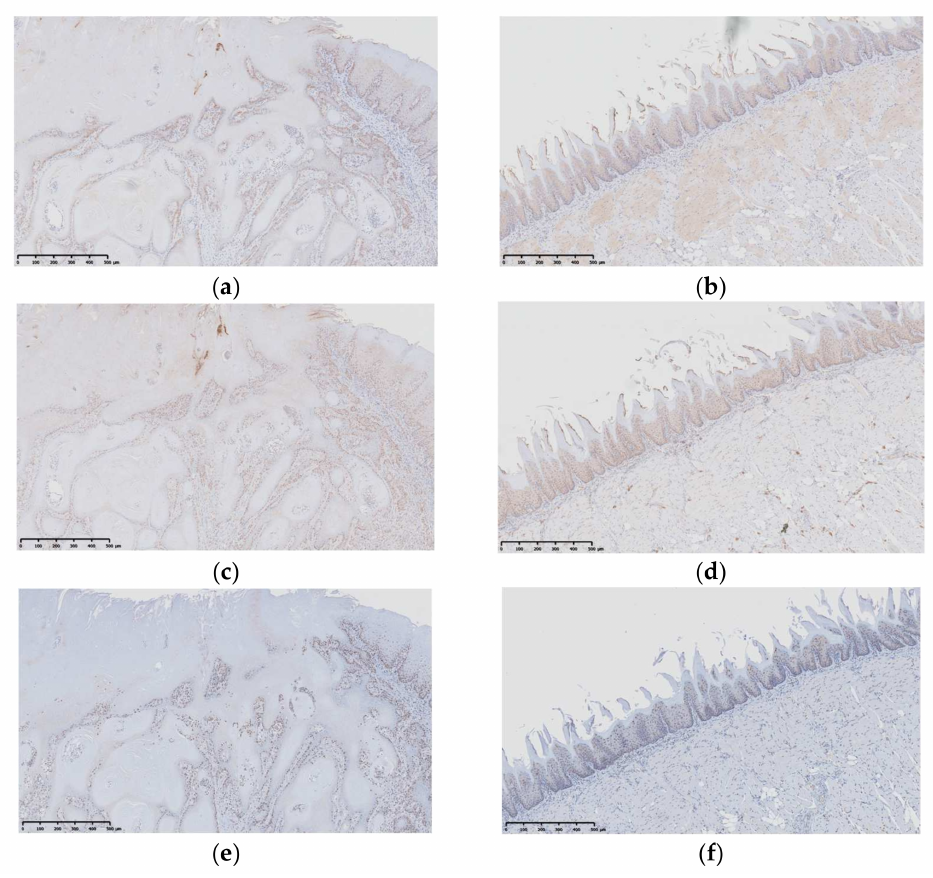
Figure 10. Photomicrographs of IHC reactions (Mic. Mag.; × 200): ( a ) Ki-67, CTRL group; ( b ) Ki-67, Film group; ( c ) NF- κ B, CTRL group; ( d ) NF- κ B, Film group; ( e ) 8-OHdG, CTRL group; ( f ) 8-OHdG, Film